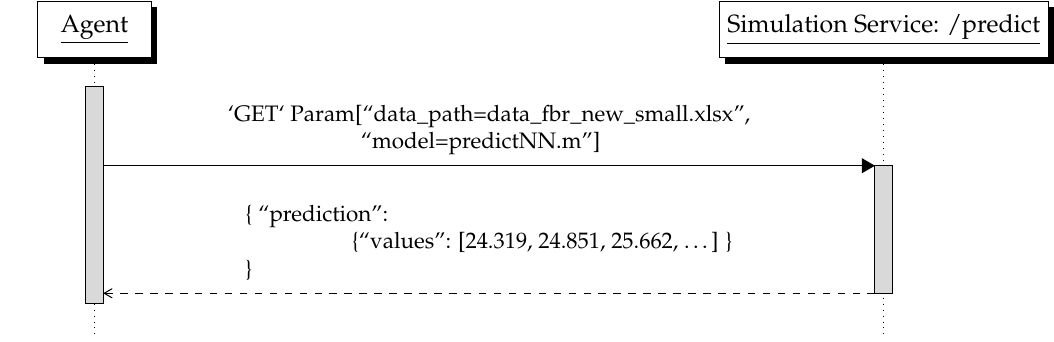
Figure 10. Sequence diagram for using a model to predict a time series at simulation